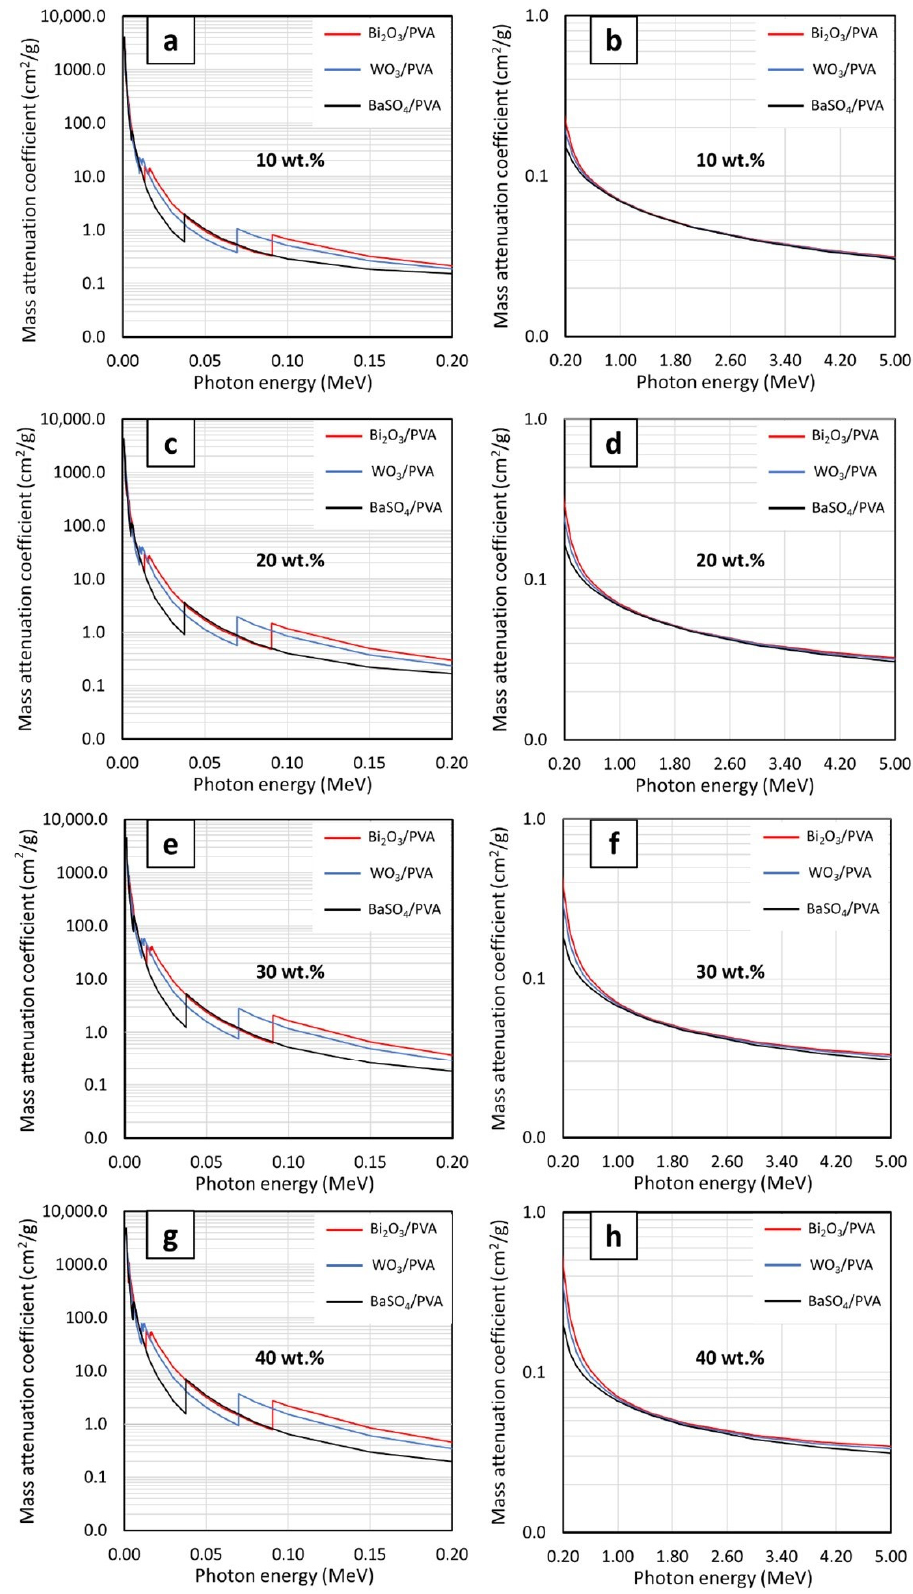
Figure 2. The µ m values of Bi 2 O 3 /PVA, WO 3 /PVA, and BaSO 4 /PVA hydrogels containing filler contents of ( a , b ) 10 wt.%, ( c , d ) 20 wt.%, ( e , f ) 30 wt.%, and ( g , h ) 40 wt.%, determined at photon energies of ( a , c , e , g ) 0.001–0.2 MeV and ( b , d , f , h ) 0.2–5 MeV using XCOM.